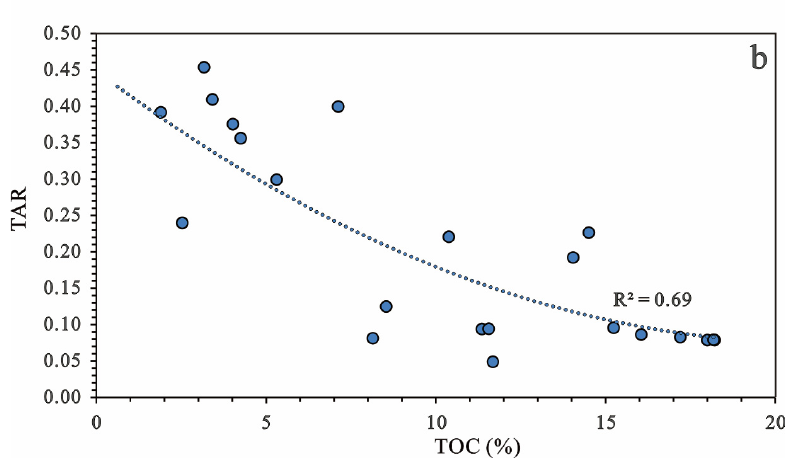
Figure 7. Cross-plots of ( a ) the wax indexes versus TOC contents, and ( b ) TAR versus TOC con-